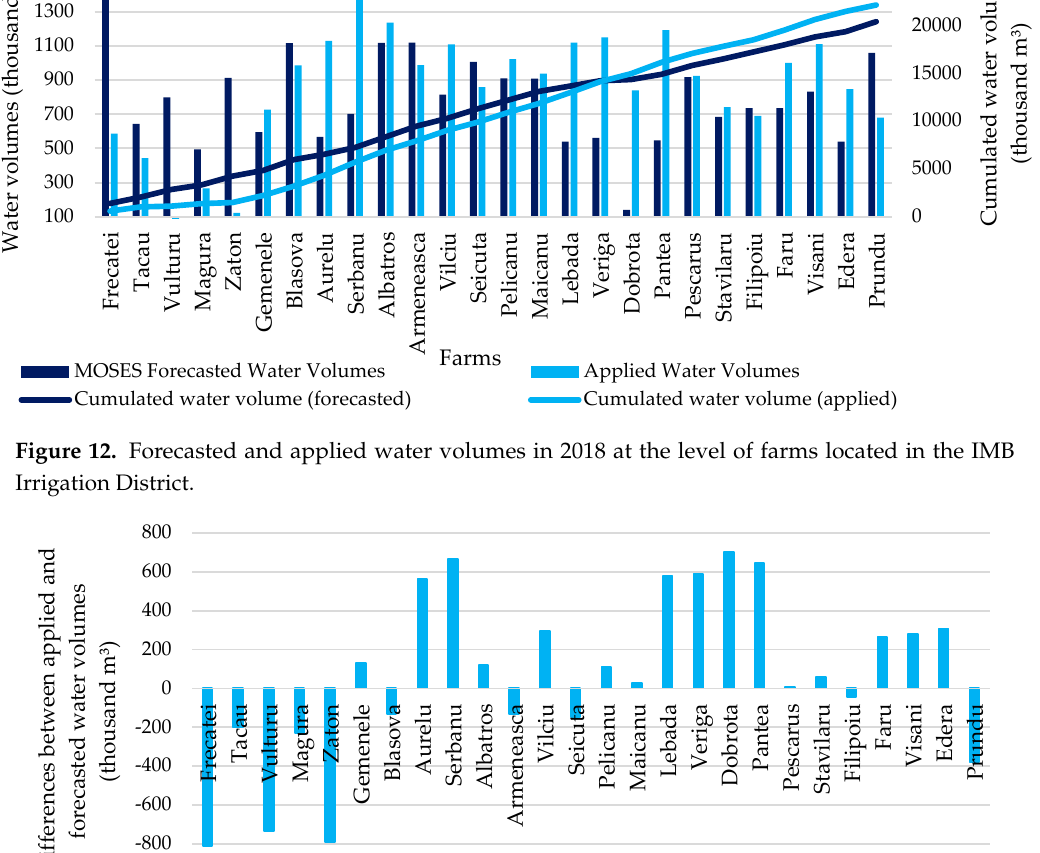
Figure 14. Forecasted and applied water volumes in 2018 at the scale of main pumping stations (SPR) located in the IMB Irrigation District. Despite the important water table contribution to crop water needs, during the spring season, the mean annual precipitation, which does not exceed 500 mm, causes irrigation to be necessary during the summer in order to avoid crop losses and to ensure high yields. As Figure 15 shows, the cereal yield obtained from irrigation in 2018, at SCDA Br ă ila farm, is double (wheat) and triple (corn)